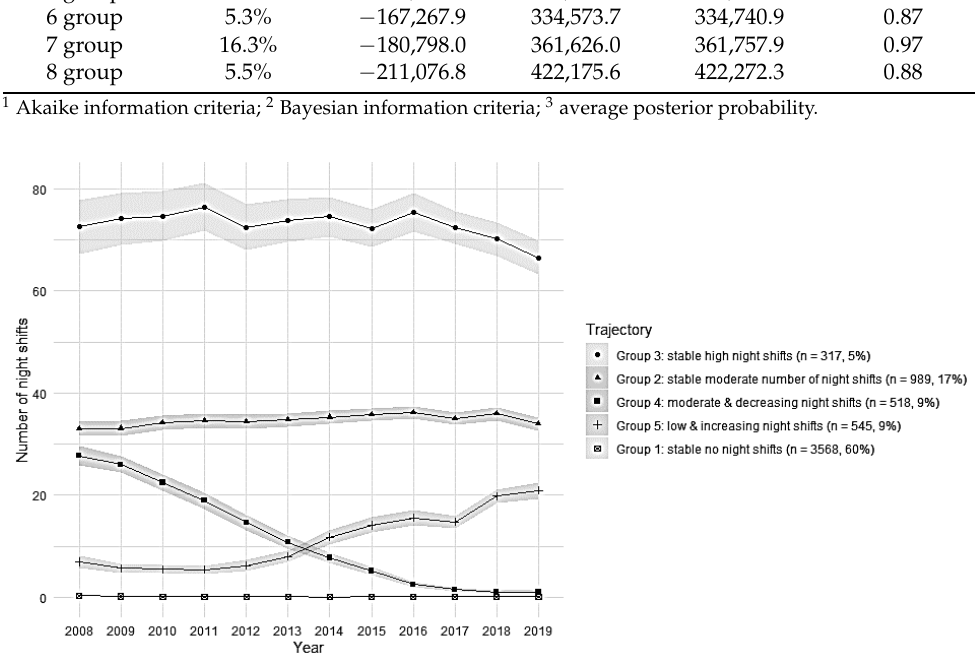
Figure 2. Trajectories of the mean annual number of night shifts with 95% CI in sample 1 ( n = 5937 employees).